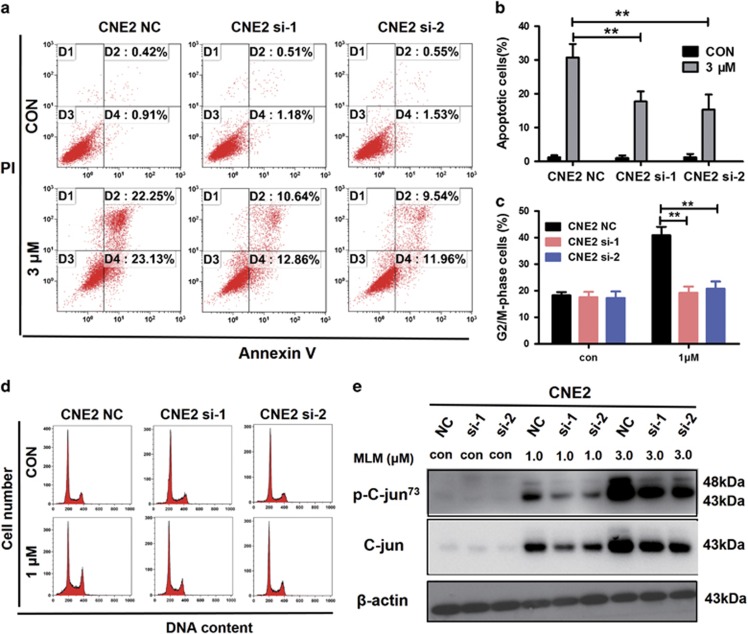
C-Jun knockdown inhibits cell apoptosis and cell cycle arrest in human NPC cell. (a,b) CNE2 (NC, si-1, si-2) were treated with MLN4924 at 3 μM for 48 h after c-Jun was transiently knocked down using siRNA (si-1 and si-2), followed by apoptosis analysis. (c,d) Cell cycle analysis was tested after CNE2 (NC, si-1, si-2) exposed to 1 μM MLN4924. (e) Western blot analysis to evaluate the expression of c-Jun, p-c-Jun, and β-actin as a loading control. Data are presented as means ±S.E.M. of three independent experiments. *P<0.05, **P<0.01 as compared with the controls